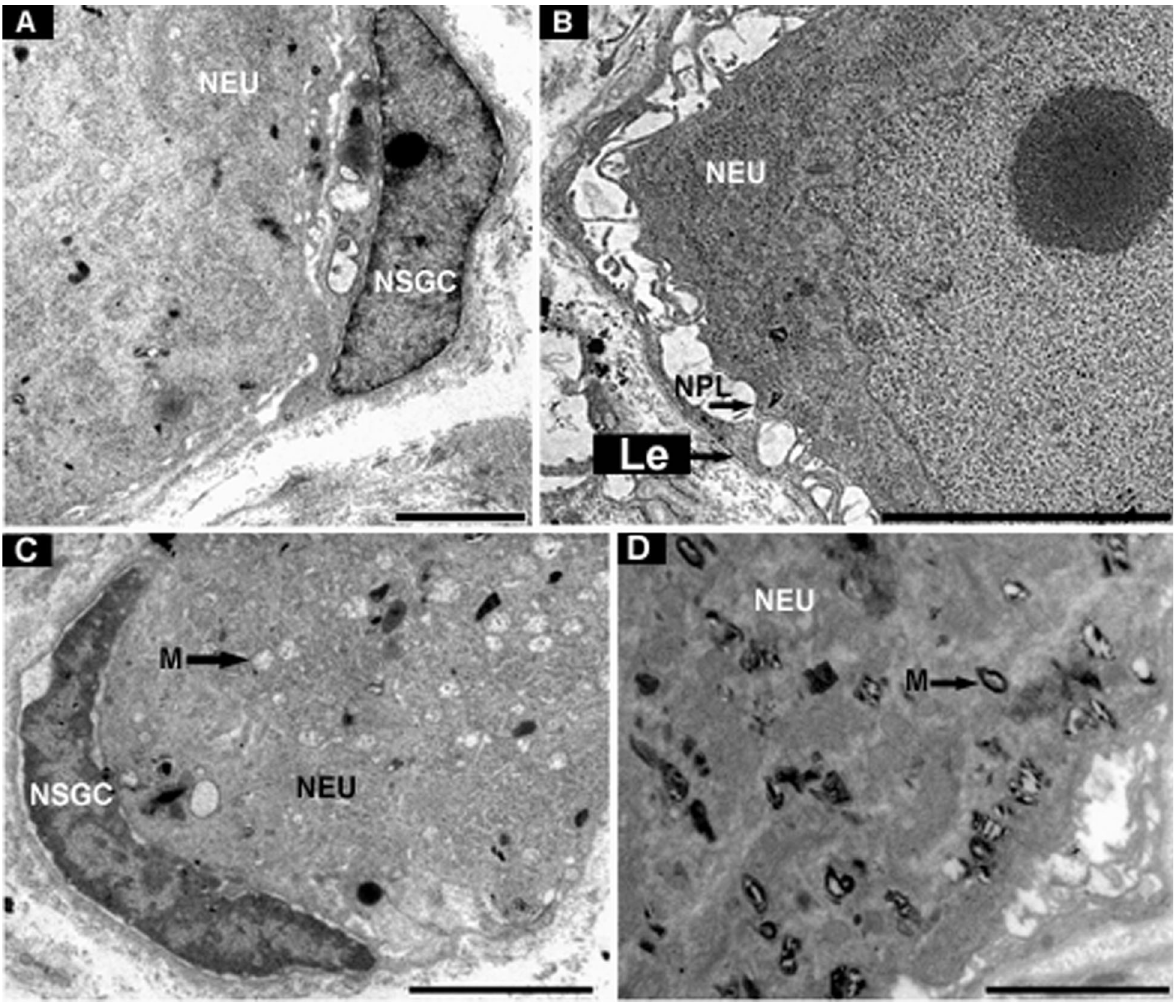
Figure 1. Cross-section of a naive ( A , B ) and transected ( C , D ) Rana catesbeiana ’s dorsal root ganglion. A , Nuclear satellite glial cells (NSGC) close to a sensory neuron (NEU). B , Lamellar cytoplasmic expansions (Le) from a satellite glial cell near the neuronal projection (NPL). C , Sensory NEU in the chromatolysis process. Note the mitochondrial (M) accumulation in the neuronal cytoplasm and the characteristic chromatin condensation in the NSGC. D , Sensory NEU in the chromatolysis process and vacuolated M. Scale bars: A (0.2 m m); B (5 m m), C and D (2 m